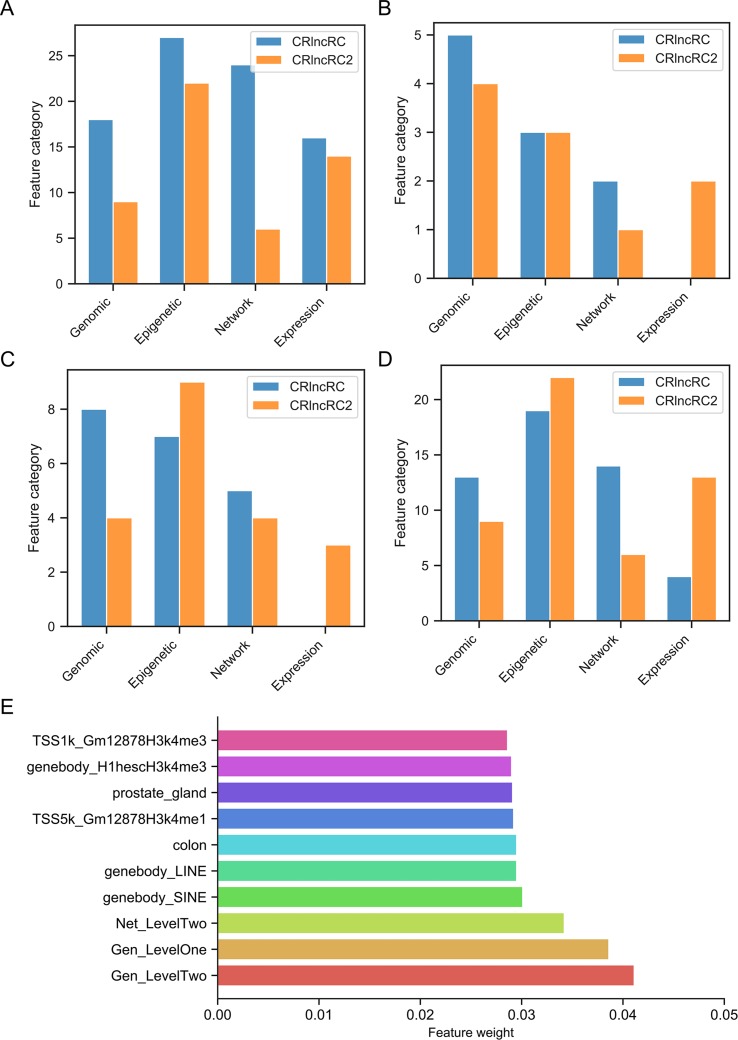
Comparison of feature numbers in the four feature categories. (A) Comparison of total features in CRlncRC2 and CRlncRC. CRlncRC contains 85 features, and after feature selection, 51 remained in CRlncRC2. (B) Comparison of the top 10 features in CRlncRC2 and CRlncRC. (C) Comparison of the top 20 features in CRlncRC2 and CRlncRC. (D) Comparison of the top 50 features in CRlncRC2 and CRlncRC. (E) Bar plot of the top 10 features used in CRlncRC2.